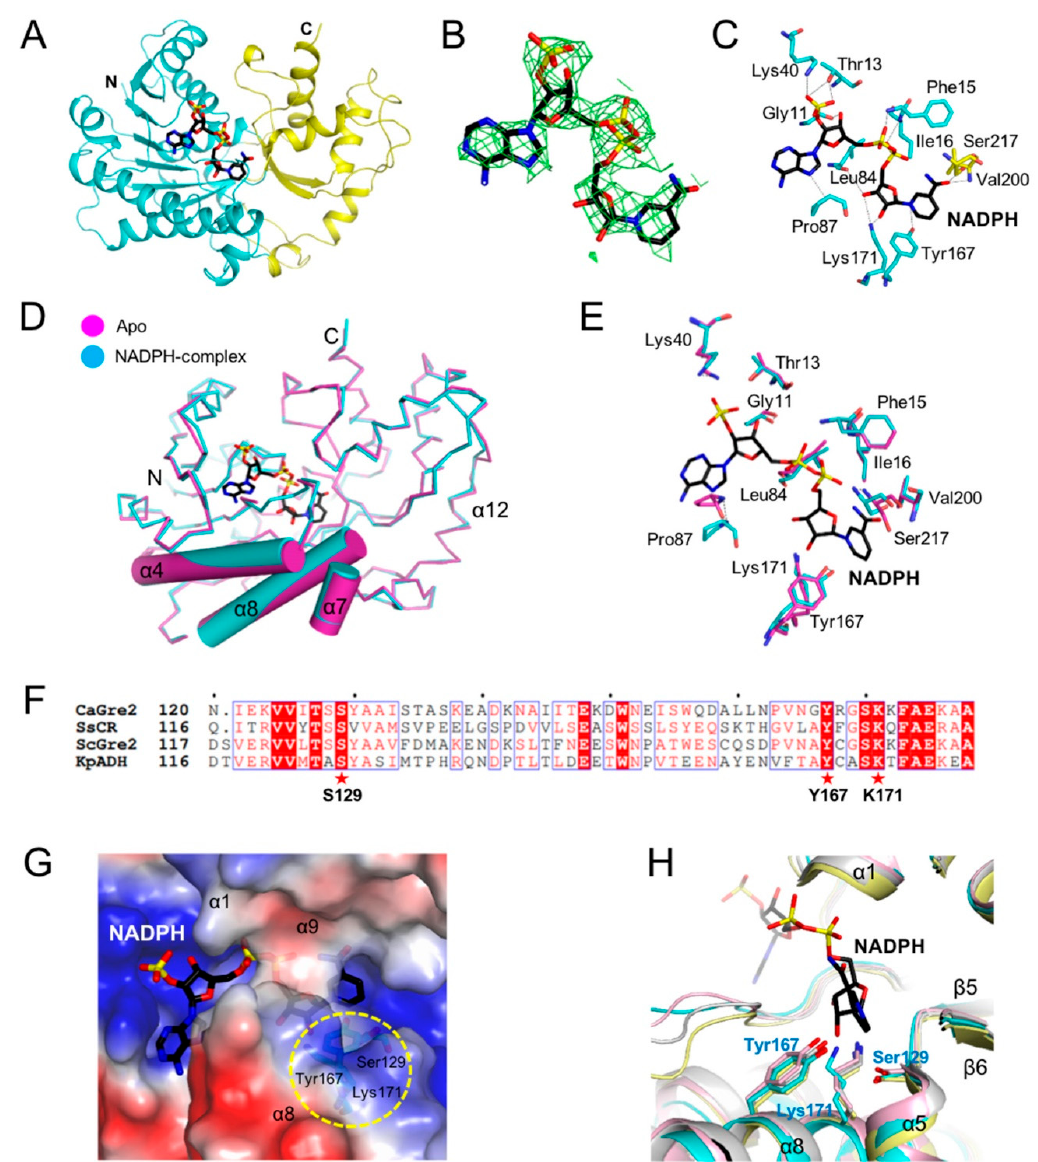
Figure 3. Ca Gre2 NADPH-complexed structure and NADPH-binding site. ( A ) Schematic representation of Ca Gre2 NADPH-complexed structure. Domains are colored as in Figure 1B. ( B ) Simulated-annealing omit Fo–Fc electron density at 3.02 Å resolution for NADPH, contoured at 2.4 σ . ( C ) Hydrogen bonds between NADPH and residues in Ca Gre2. Hydrogen bonds are shown as black dashed lines. Residues are colored according to their domain, as in Figure 1B. Comparisons of ( D ) overall structures and of ( E ) residues participating in NADPH-binding in structures of the apo-form and NADPH-complexed form of the Ca Gre2 protein. The Ca Gre2 apo-form is shown in magenta. The Ca Gre2 NADPH-complexed form is shown in cyan. ( F ) Multiple sequence alignment of Ca Gre2 (KGQ86193.1), Ss CR (XP_001384998.1), Sc Gre2 (NP_014490.1), and Kp ADH (XP_001644505.1) by using ClustalW [25] and ESPript [26]. The catalytic triad (S129-Y167-K171) in Ca Gre2 is marked with a red star. ( G ) Electrostatic surface presentation of the NADPH- and substrate-binding pockets. The location of catalytic residues is marked by a yellow circle. ( H ) Superposition of the catalytic triads in Ca Gre2 (cyan), Sc Gre2 (PDB code, 4PVD; light pink), Ss CR (PDB code, 5YW4; yellow), and Kp ADH (PDB code, 5Z2X; light gray). Residue numbering corresponds to Ca Gre2. NADPH is indicated in black.